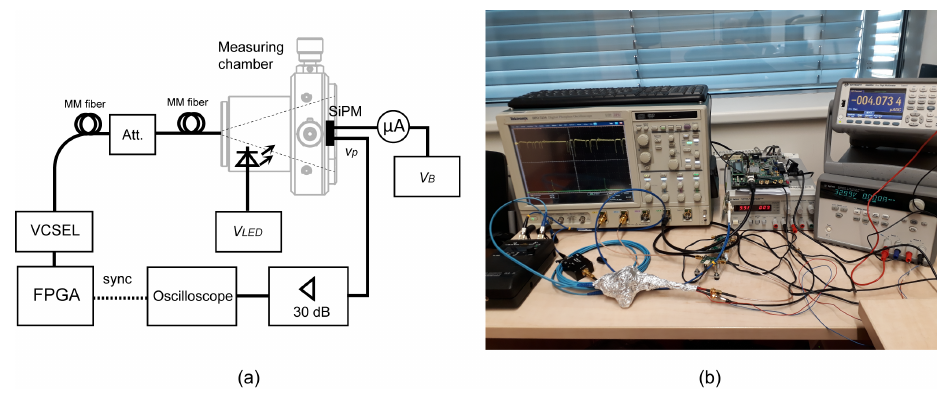
Figure 9. Block diagram ( a ) and photograph ( b ) of the experimental setup. The measuring chamber is wrapped in aluminum foil to block the ambient